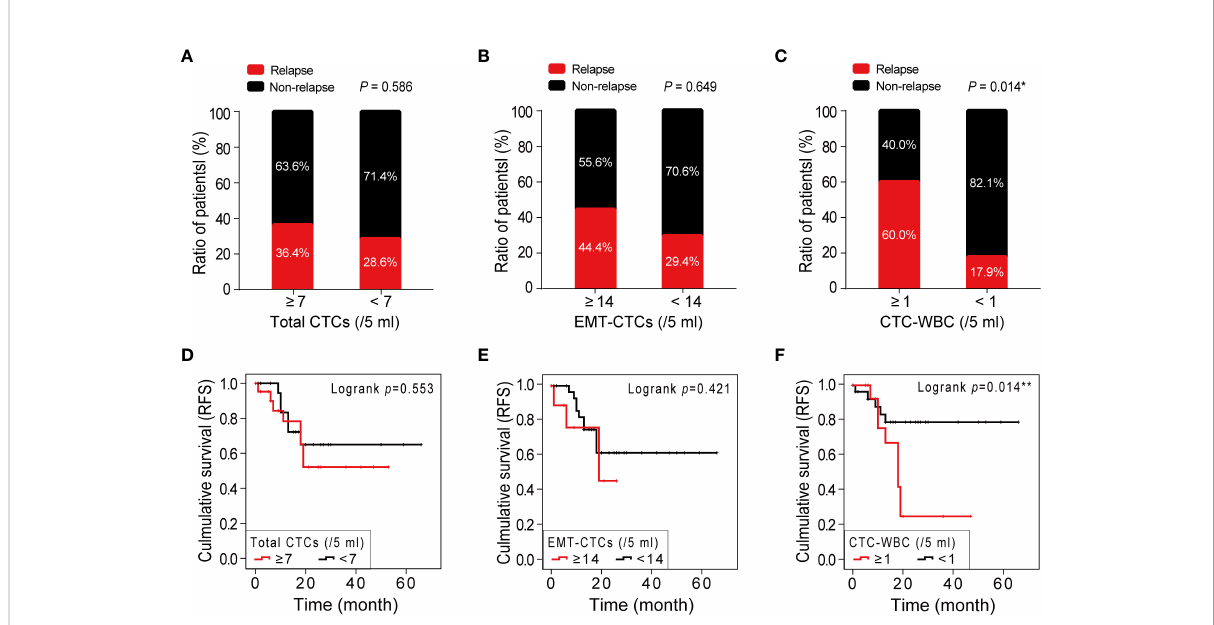
FIGURE 4 Correlations between the number of CTC parameters (total CTCs, EMT-CTCs, and CTC-WBC cluster) and HCC prognosis. (A – C) A comparison of the relapse ratio between the high and low groups of total CTCs (A) , EMT-CTCs (B) , and CTC-WBC cluster (C) . (D – F) The Kaplan – Meier survival curves of the high and low groups of total CTCs (D) , EMT-CTCs (E) , and CTC-WBC cluster (F) . * P < 0.05 and ** P <